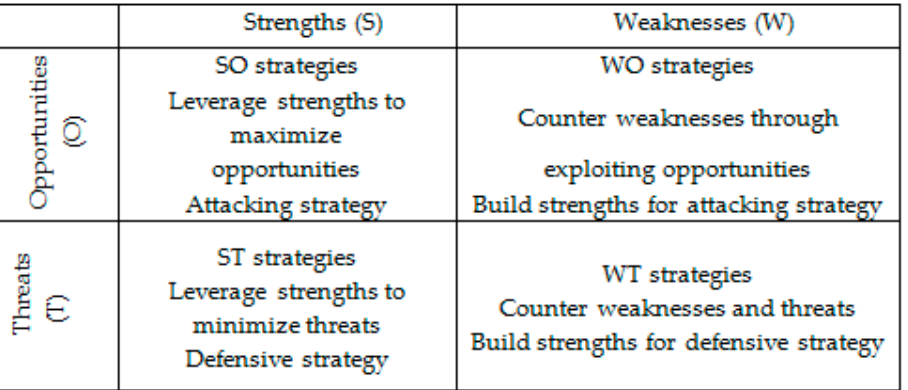
Figure 1. TOWS matrix: strategic alternative of the SWOT analysis.